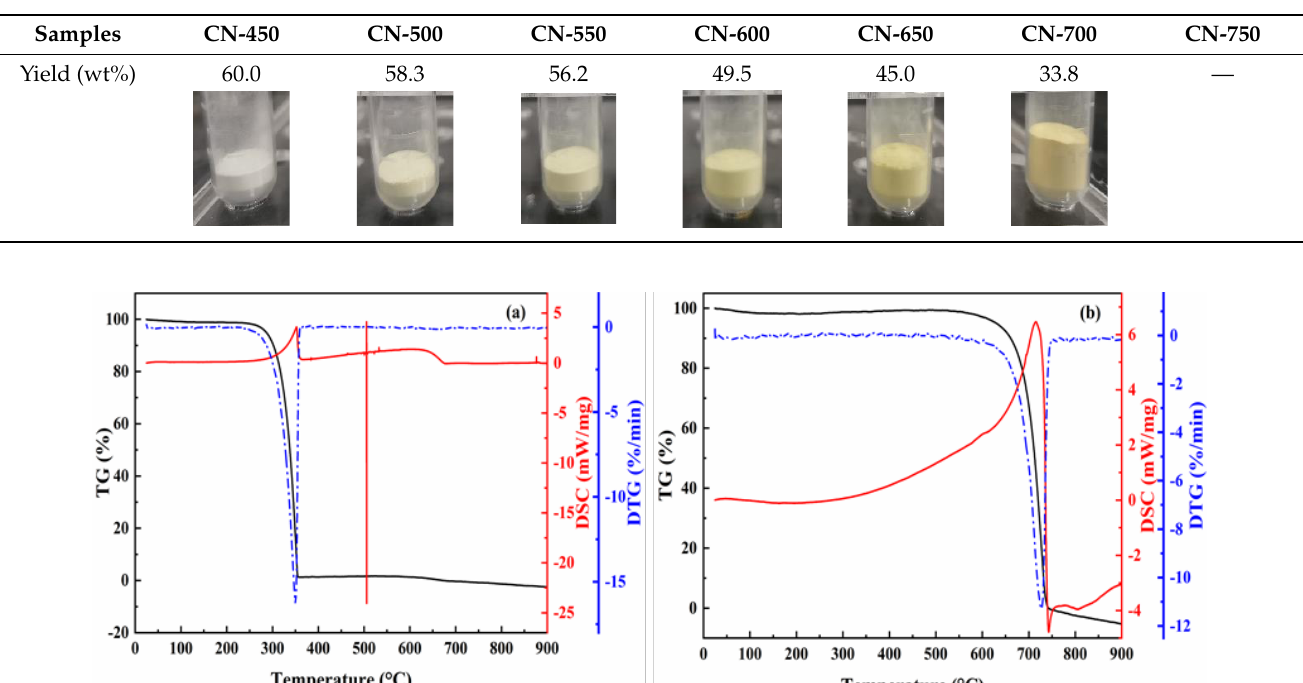
Figure 1. TG-DTG-DSC curve of ( a ) melamine and ( b ) CN-700.